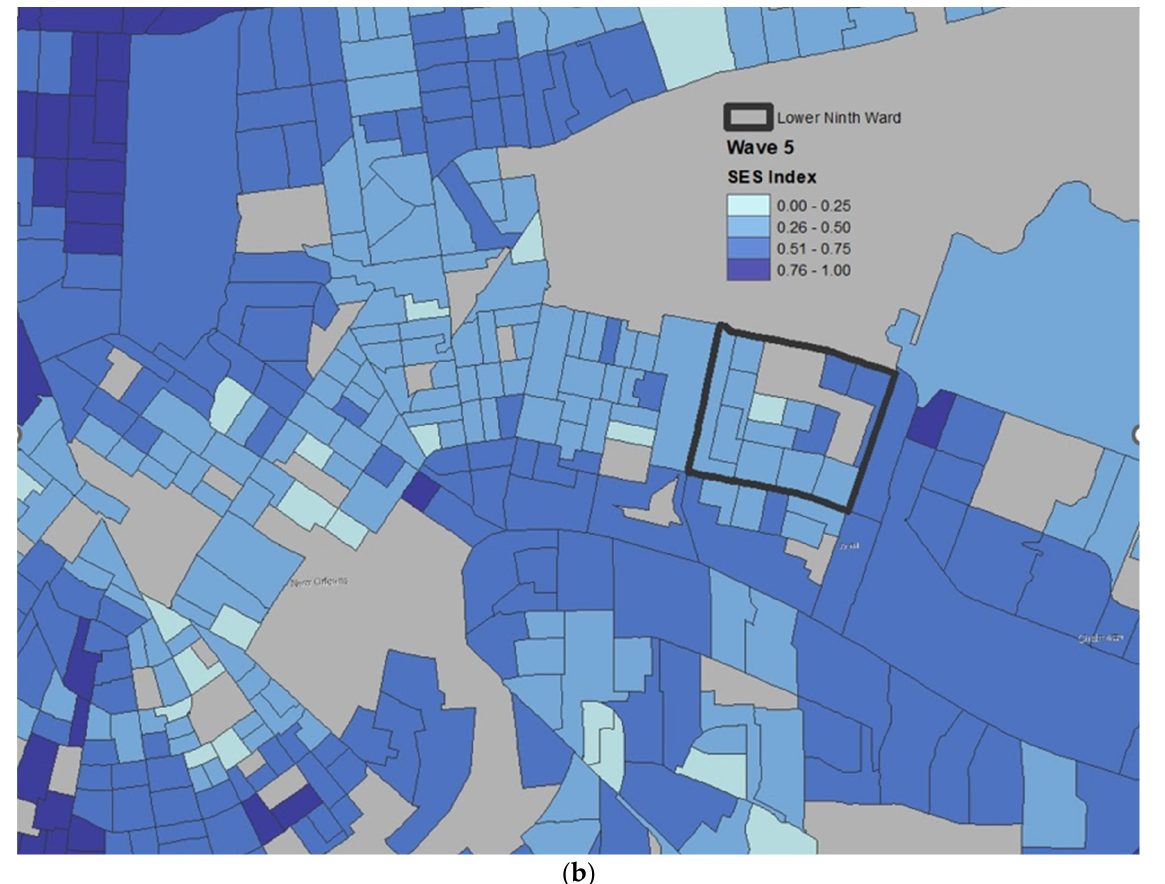
Figure 1. Thematic visualization of neighborhood socioeconomic index (SES) score in New Orleans at ( a ) Pre-Katrina (2005) and at ( b ) Wave 5 (2015). Darker gradients suggest relatively increased SES at the census block group level.